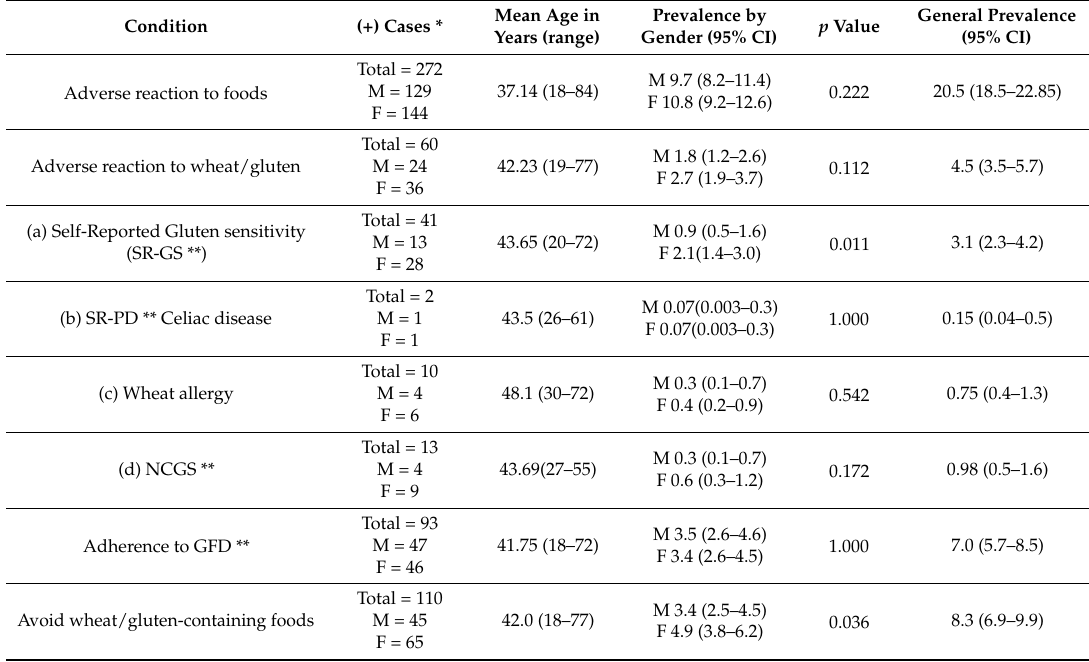
Table 2. Self-reported prevalence rates.